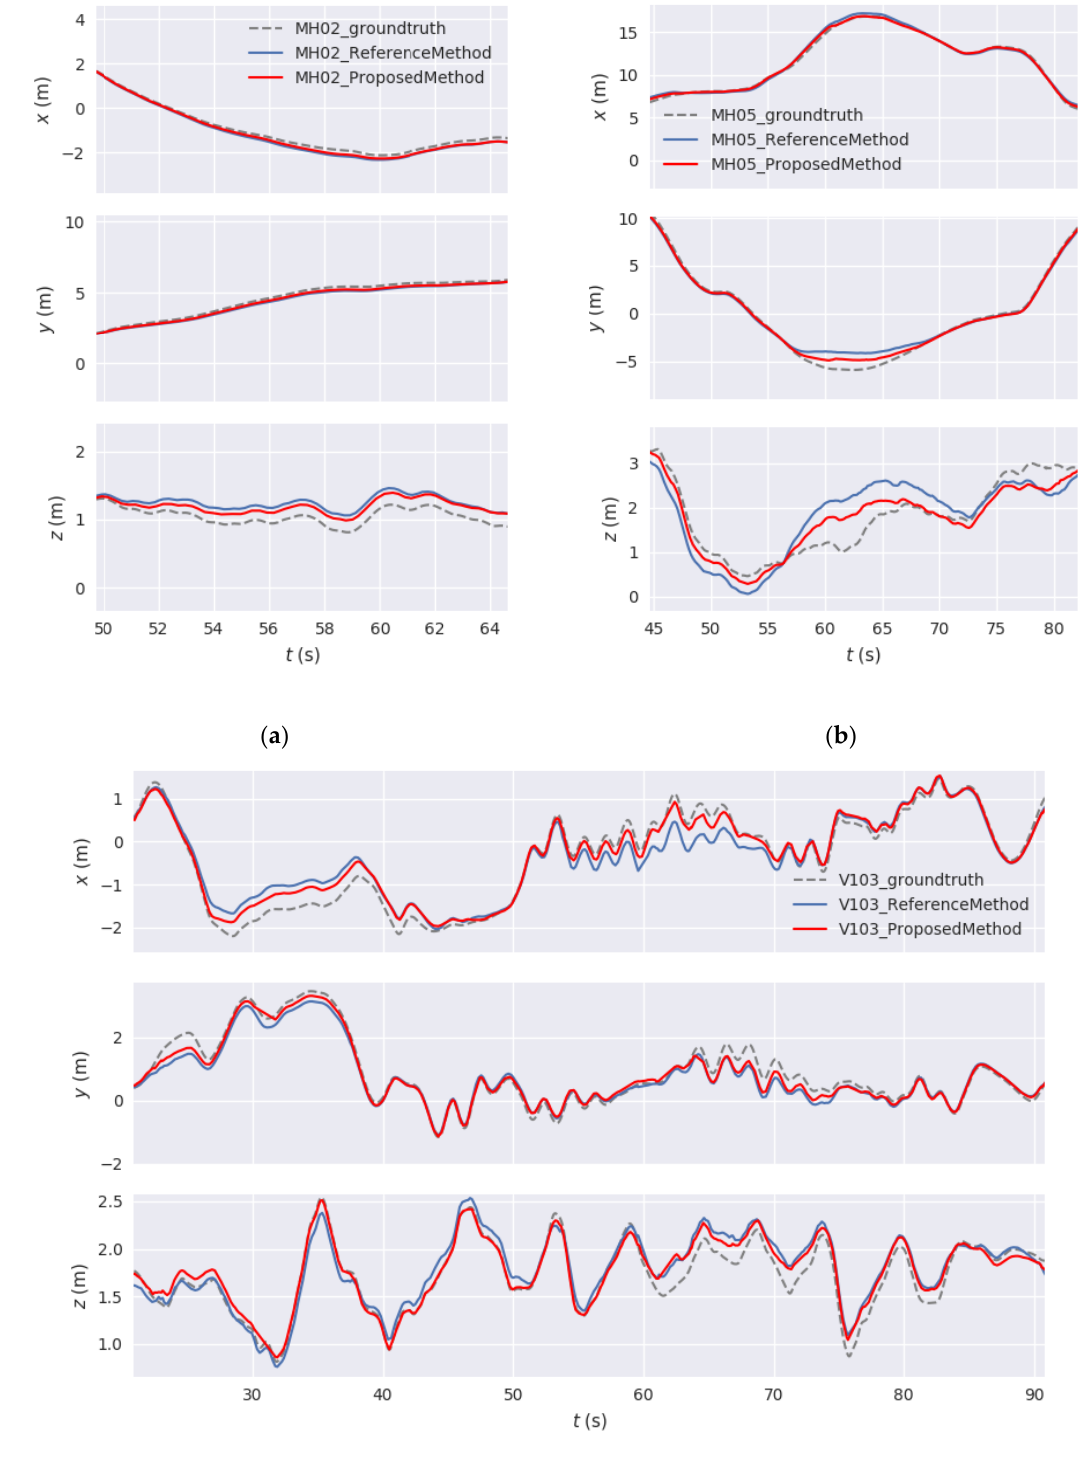
Figure 8. Accuracy of reference method (blue) and our proposed method (red) on the three coordinate axes. ( a ) 50–64 s part of MH_02_easy dataset; ( b ) 45–80 s part of MH_05_difficult dataset. ( c ) 25–90 s part of V1_03_difficult dataset. The trajectories of our proposed method are closer to the ground truth than those of reference method when the camera has large fluctuation.